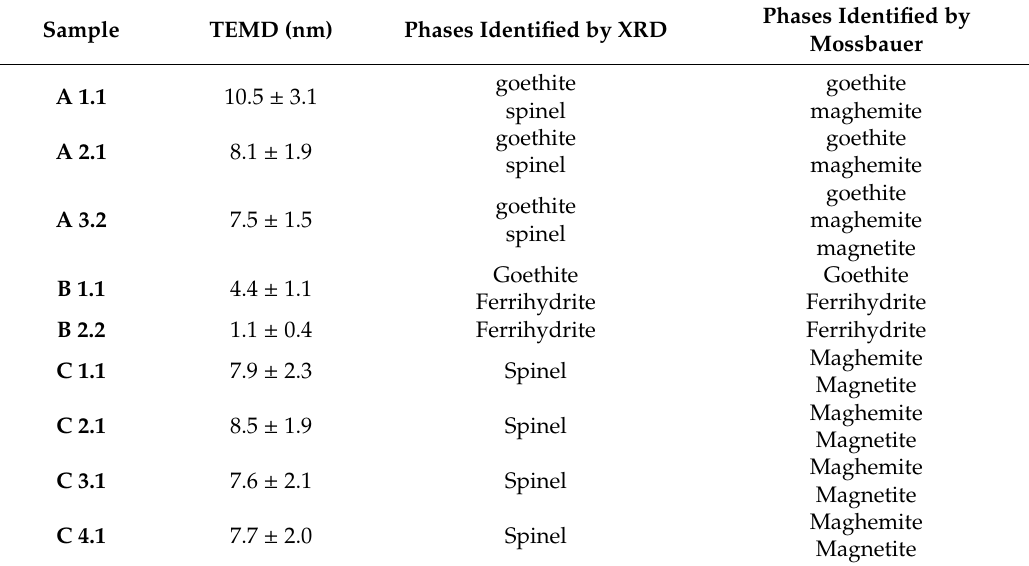
Table 3. Average (static) diameter and phase composition of naked and coated